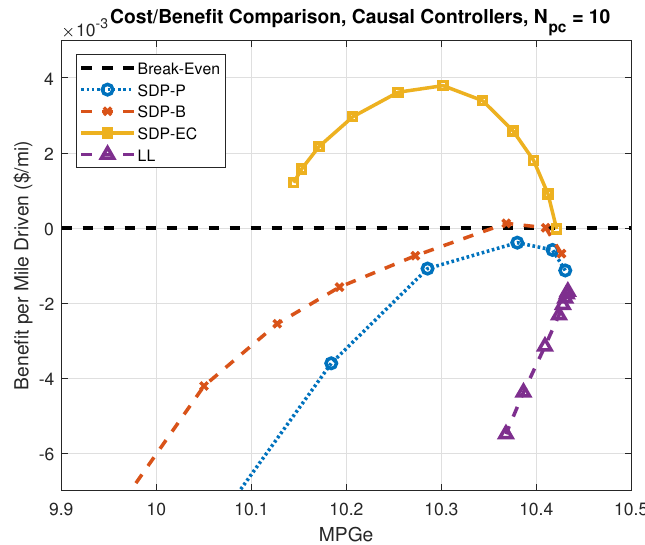
Figure 12. Cost–benefit analysis for the four causal control methods, N pc = 10.